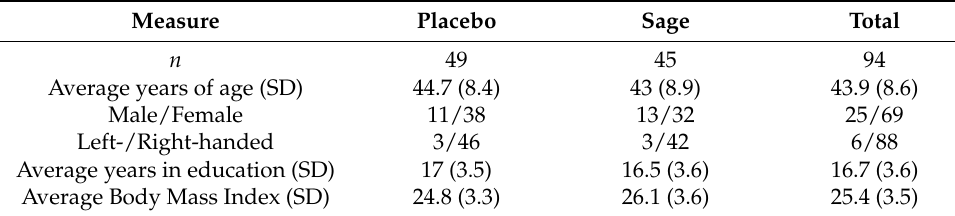
Table 1. Participant demographics for the placebo and sage